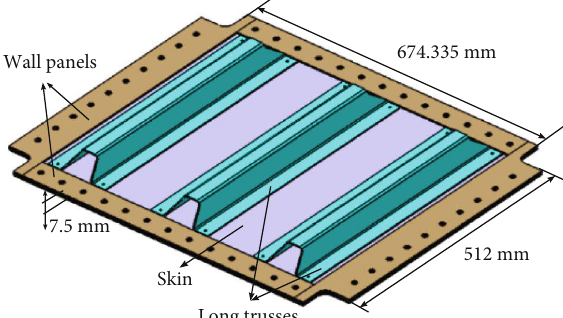
Figure 1: Cap-type-reinforced composite wall panel structure.